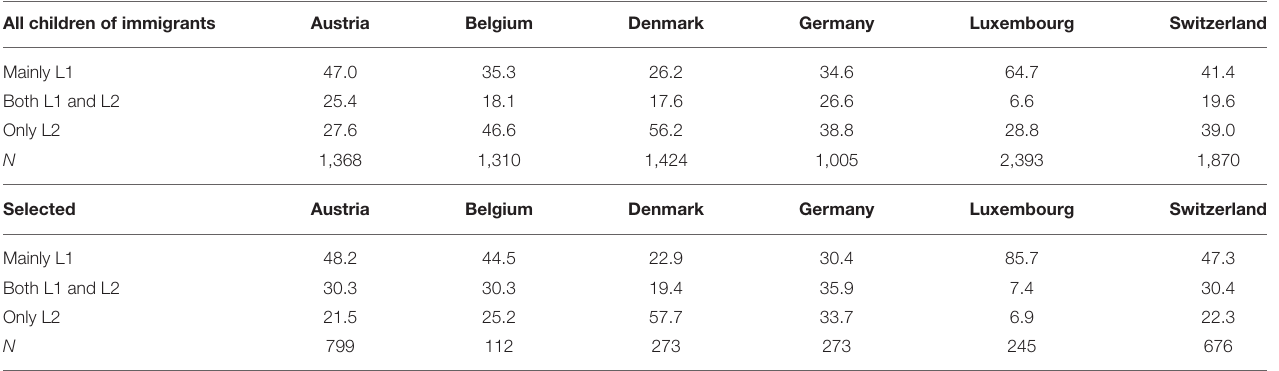
TABLE 2 | Distribution of language use groups (%) among all children of immigrants (upper panel) and youth with origins in Turkey and former Yugoslavia (lower panel). All children of